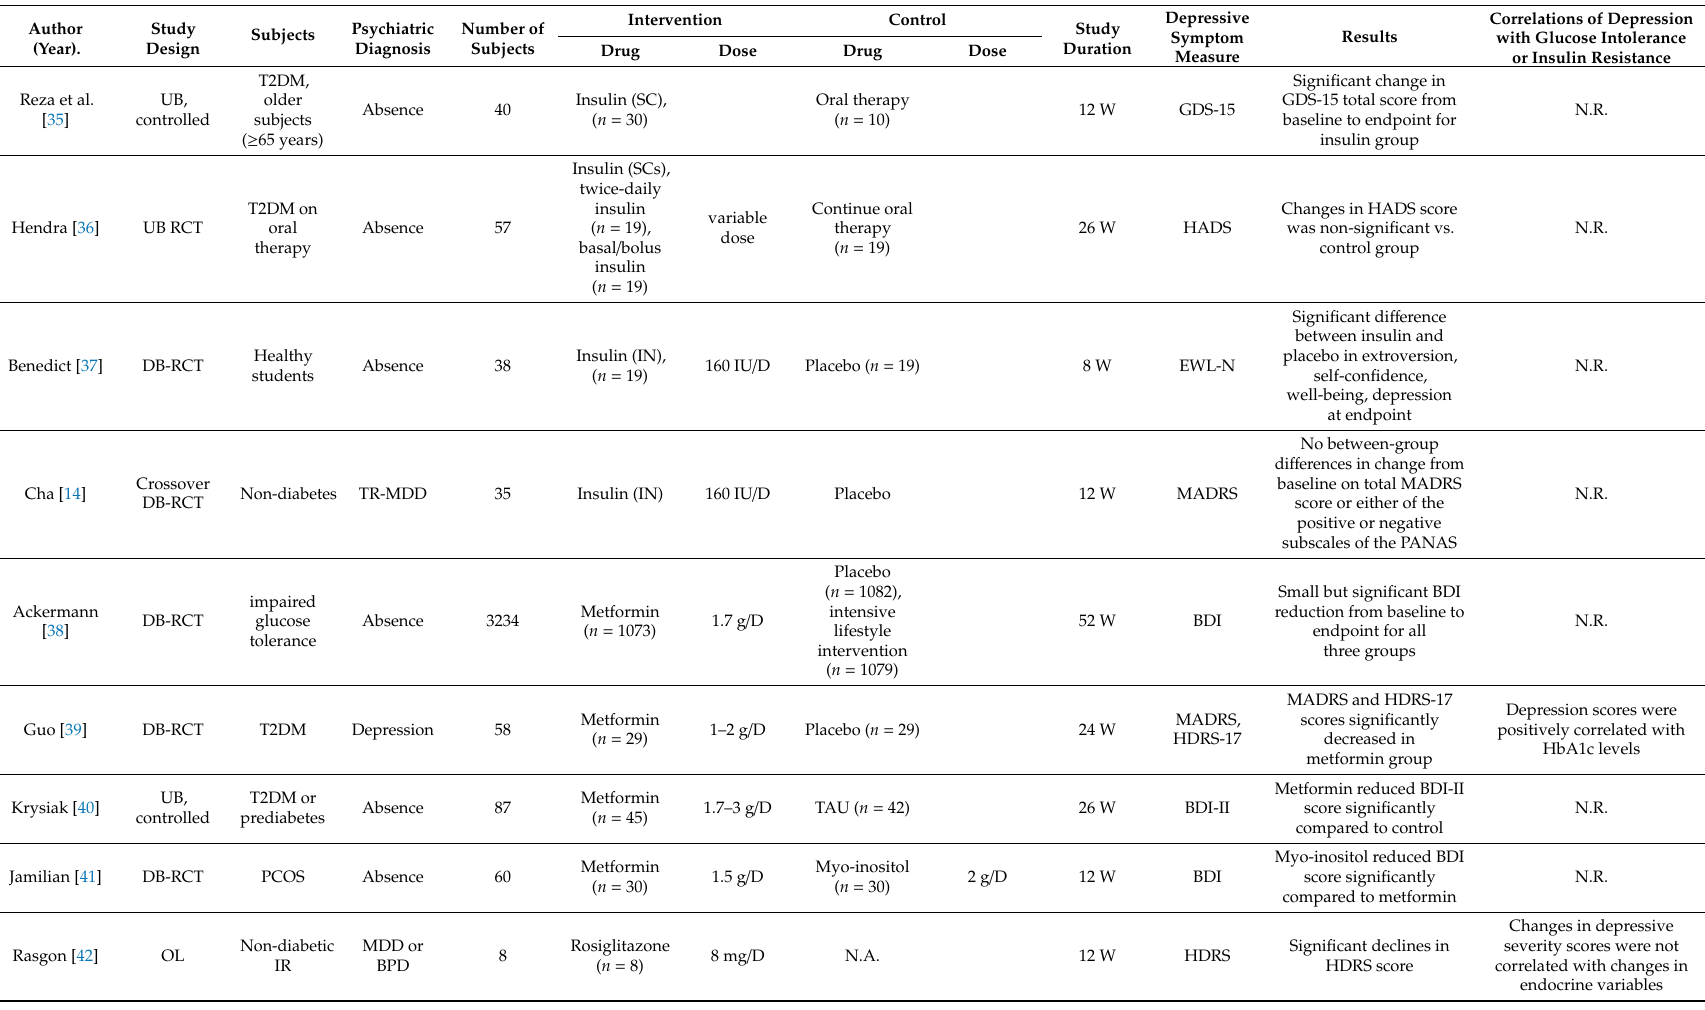
Table 1. Characteristics of prior studies investigating antidepressant e ff ects of anti-hyperglycemic